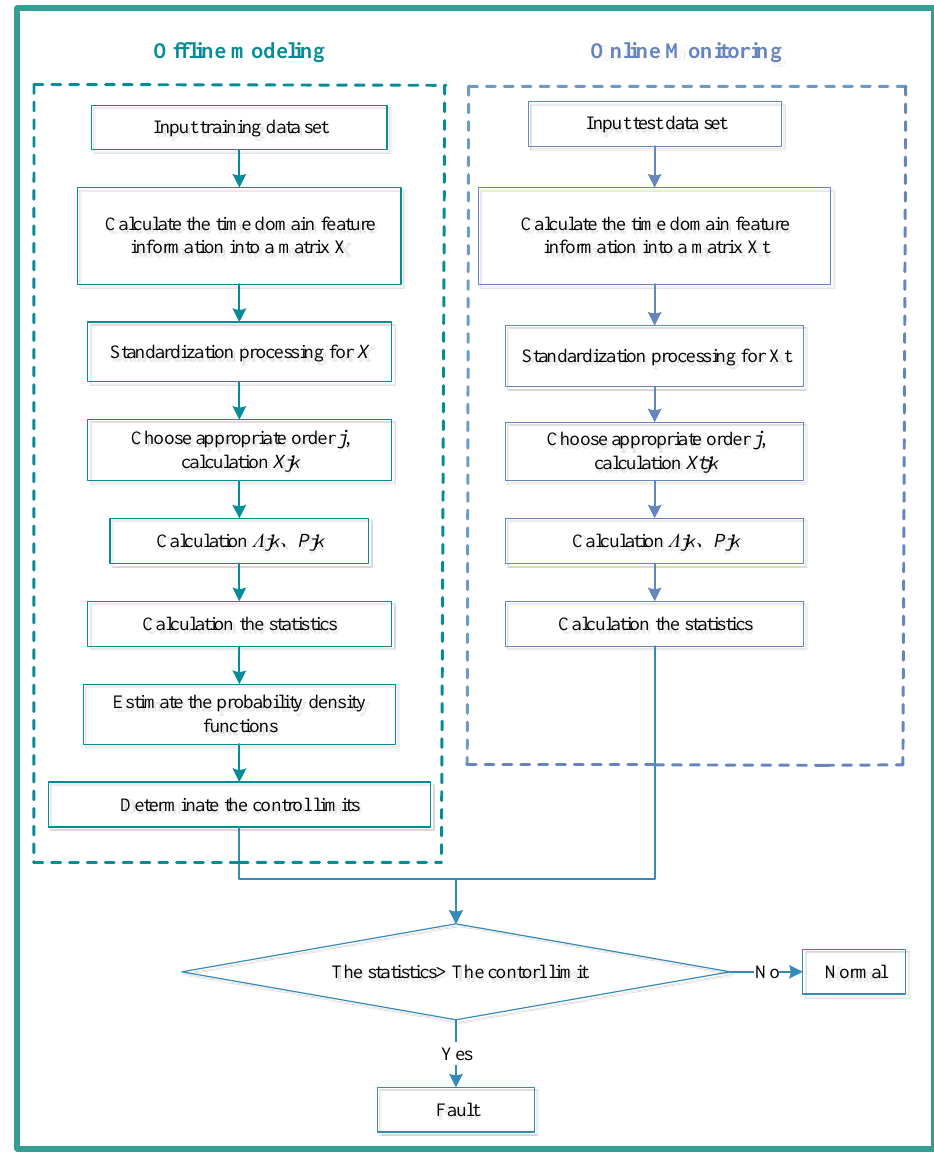
Figure 2. The process of ID-PCA.